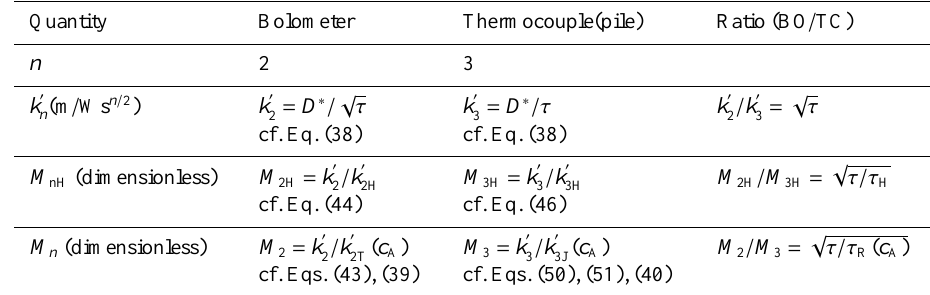
Table 1. Summary of the figures of merit for bolometers and thermocouples / thermopiles. Quantity Bolometer